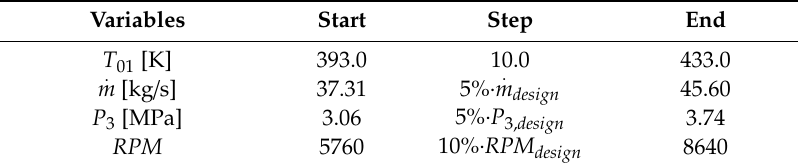
Table 7. Information on variable changes for o ff -design